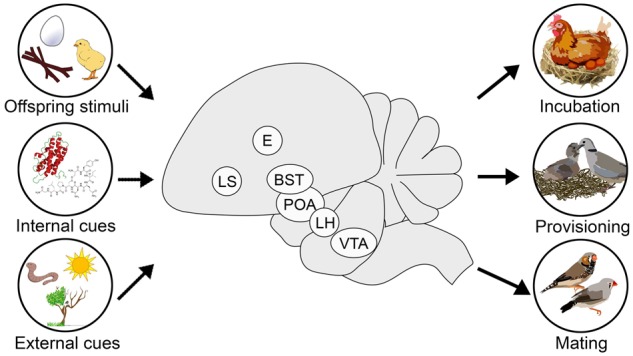
Integration of information from offspring cues, internal physiology, and the environment is performed by core brain regions important for parental behavior in birds, such as promoting egg incubation and offspring provisioning while rejecting mating opportunities. Information on brain regions important for parental behavior incorporated from the following publications: chickens: Chokchaloemwong et al. (2013); ring doves: Buntin et al. (2006); quails: Ruscio and Adkins-Regan (2004); zebra finches: Hall et al. (2014). BST, bed nucleus of the stria terminalis; E, ectostriatum; LH, lateral hypothalamus; LS, lateral septum; POA, preoptic area; VTA, ventral tegmental area.